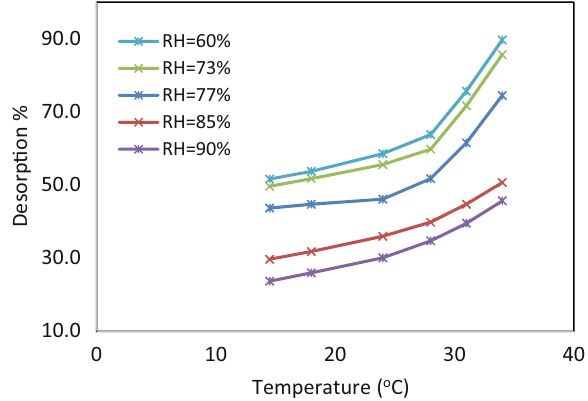
Fig. 3 Effect of temperature on desorption rate of MCA.